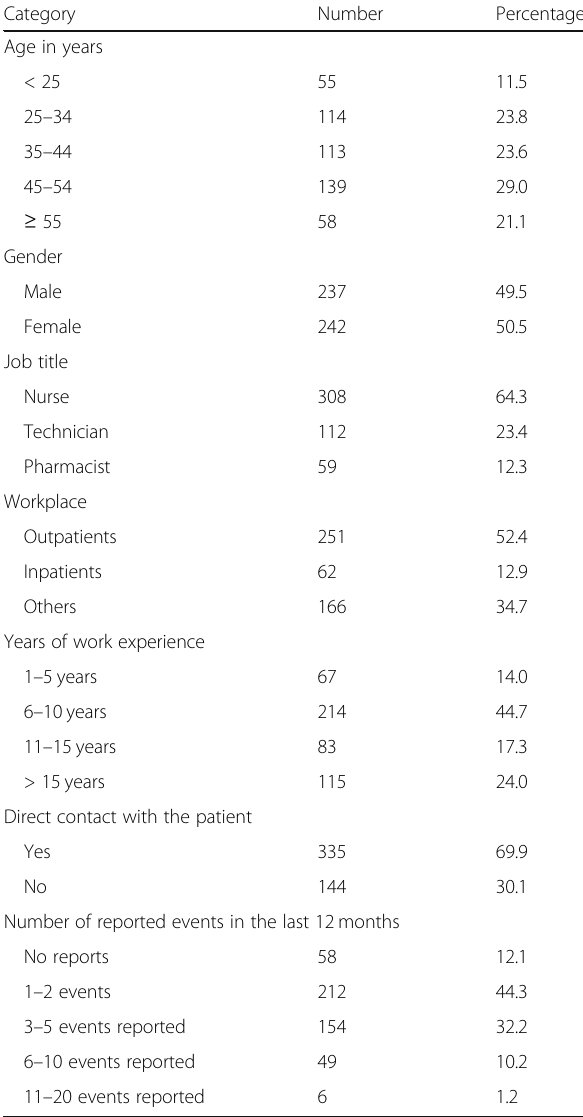
Table 1 Basic characteristics of paramedical participants at Fayoum General Hospital and other selected district